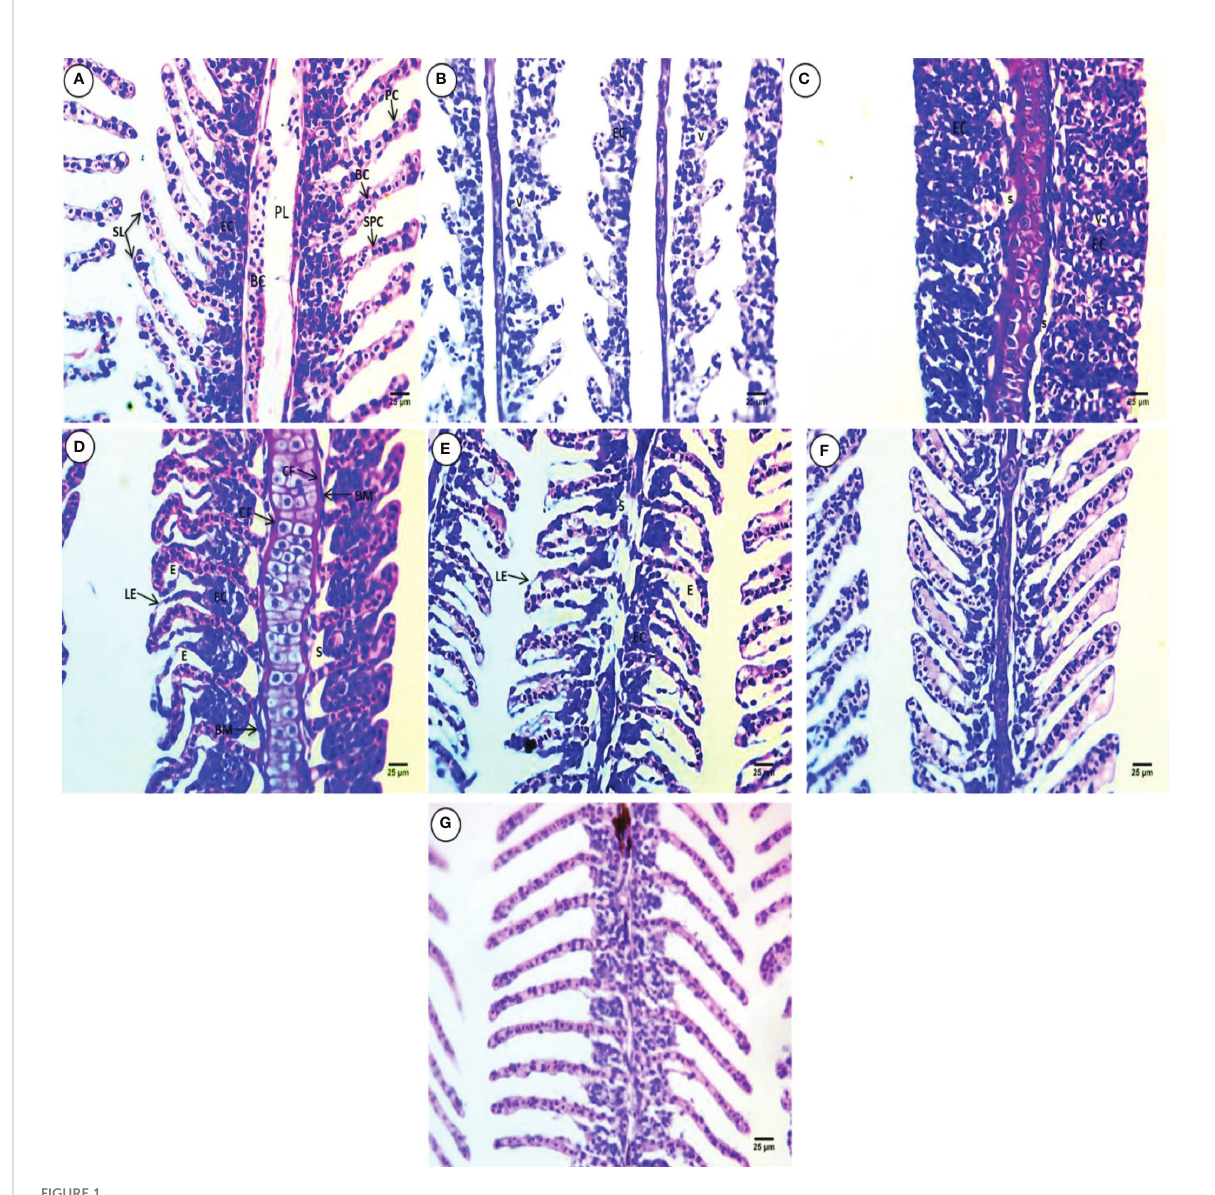
FIGURE 1 H & E-stained gill sections of common carp showing the normal morphological structure of the control group (A) and selected deformations after treatment with10 mg/L PE-MPs (B, G) , 10 mg/L PE-MPs + 200 µg/L 4-NP (C, F) , and 200 µg/L 4-NP (D, E) , as (B, C, E) for exposure period and (D, F, G) for post exposure period. Primary lamellae (PL), secondary lamellae (SL), epithelial cells (EC), blood capillaries (BC), pavement cells (PC), supportive pillar cells (SPC), vacuoles(V), space (S), connective fi bers (CF), basement membrane (BM), lifting epithelium (LE), and edema